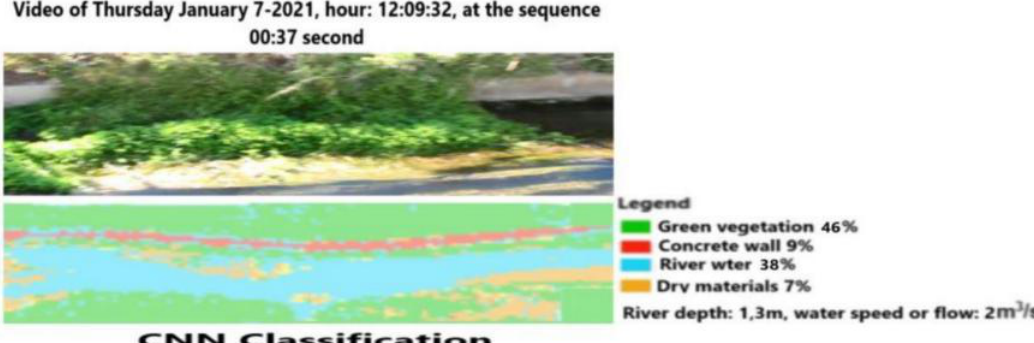
Figure 18. Video frame classification based on normal CNN-evolutionary fuzzy integral (EFI) at 12:09:32 and the successive